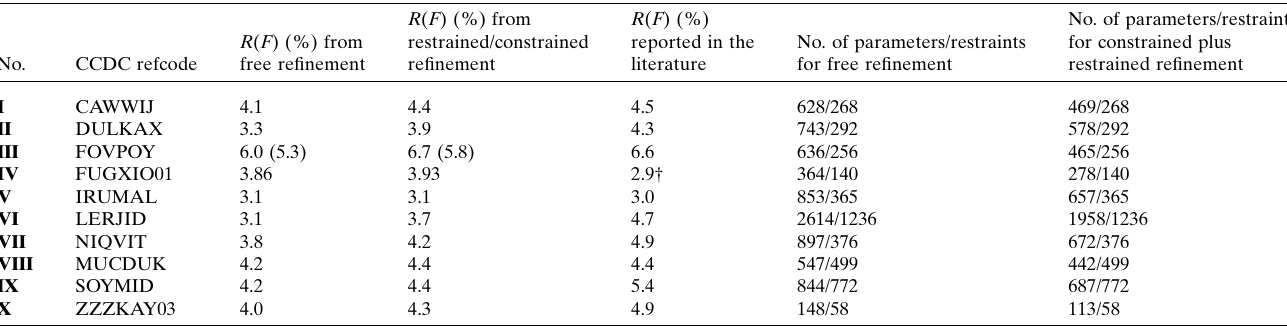
Table 1 A summary of the three refinement results reported in the main text. For refcode FOVPOY, the data (in brackets) were cut to a resolution of 0.84 A˚ .